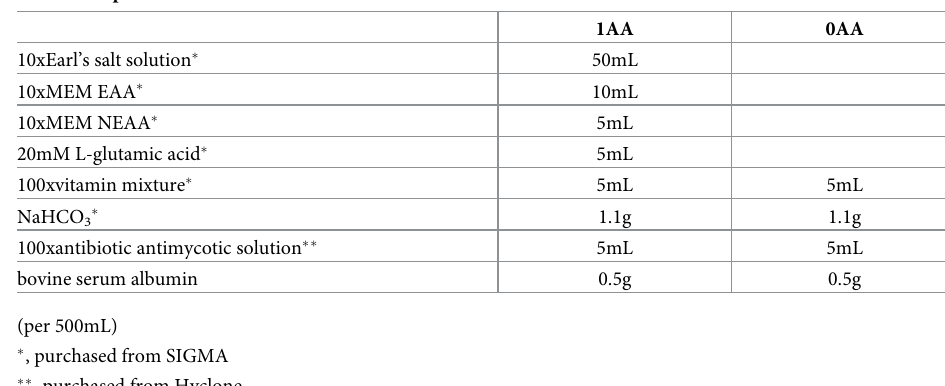
Table 2. Experimental